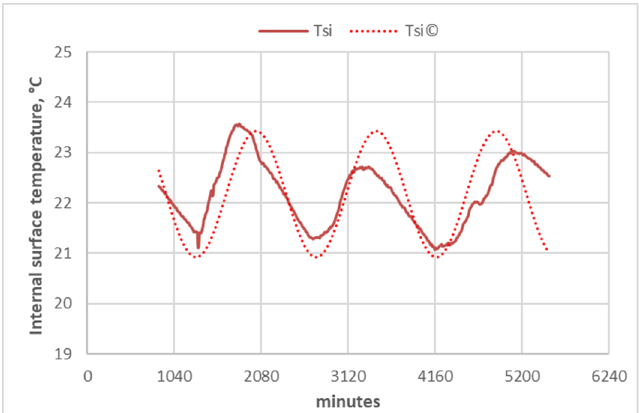
Figure 22. Casa Cembo straw wall: internal surface temperatures (measured data indicated with the continuous line and calculated data with the dotted line).